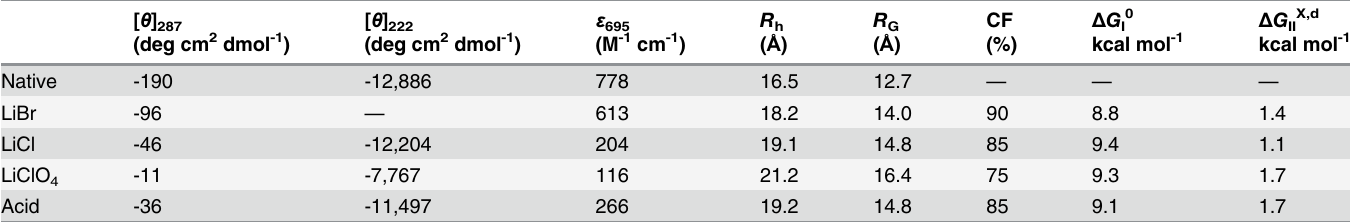
Table 2. Structural and thermodynamic properties of various molten globule (MG) states of cyt- c at 25°C and pH 6.0. [ θ ]